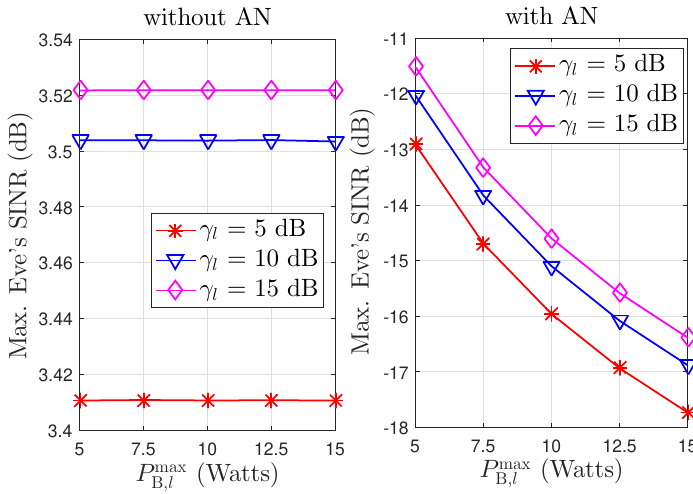
Figure 2. Maximum Eve’s SINR according to maximum allowable BS’s power in a perfect channel